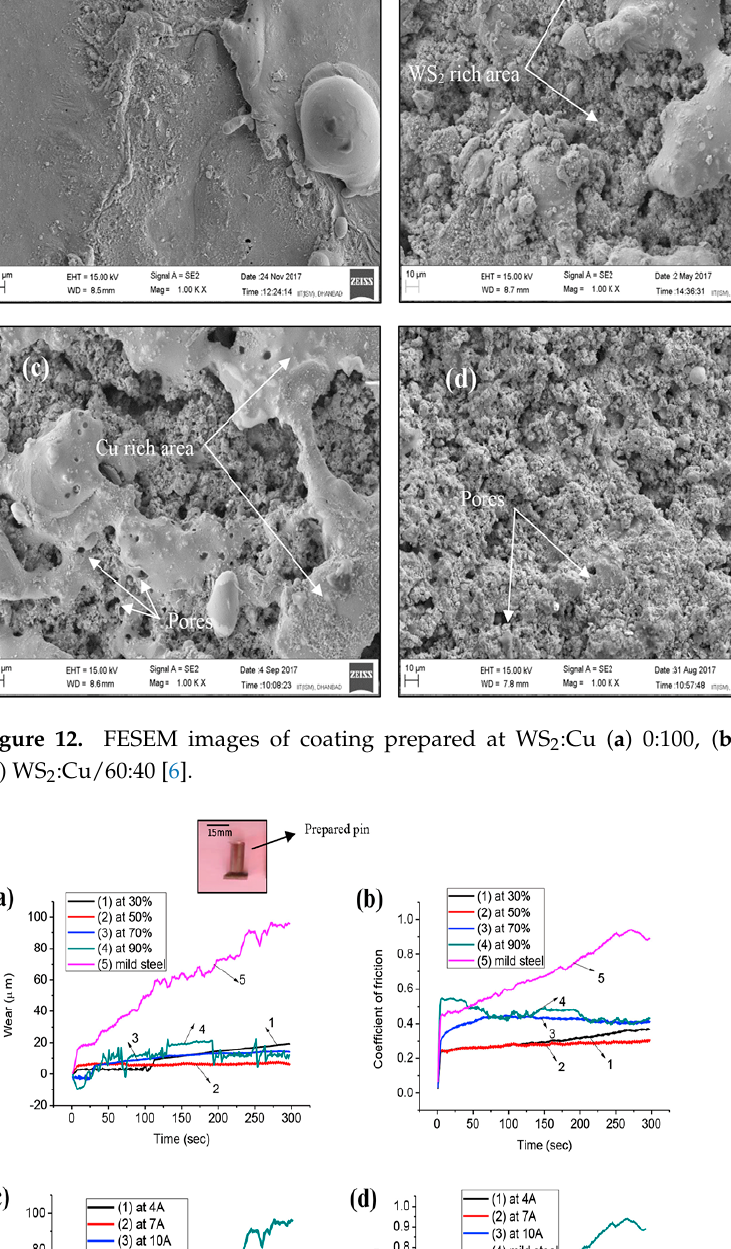
Figure 13. ( a , c ) Wear and ( b , d ) coefficient of friction performance of coated surface [6]. In recent research work, the lubricating coating was also fabricated over mild steel substrate by using powders of hBN and Cu for making compact electrodes and used as an EDM tool. The effect on morphology, tribological performance, and hardness of the hBN − Cu coating layer were discussed. FESEM images ensured fewer pores in the coating prepared at hBN: Cu/50:50, 10 A current, and 70% duty factor. Due to soft lubricant nature of hBN, the microhardness drastically reduced up to 75.76 HV. Moreover, the tribological behavior outcome showed the lubrication nature of hBN, indicating a large drop in the